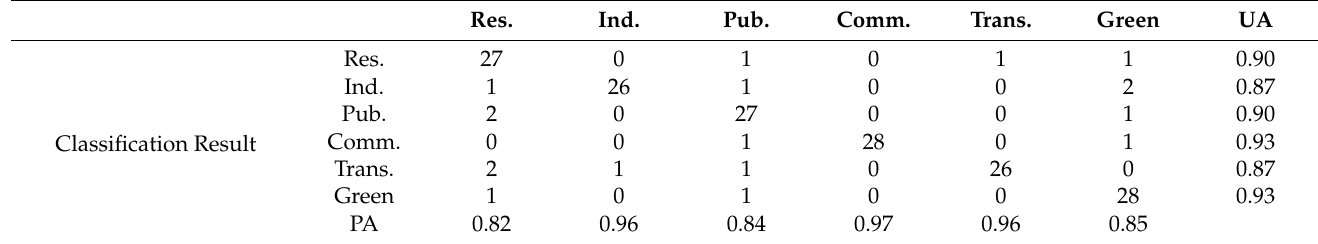
Table 4. Fused data identification confusion matrix with 30 spatial units. Res. Ind. Pub. Comm. Trans. Green UA